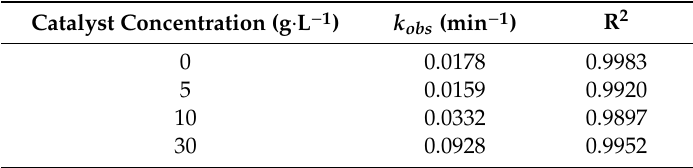
Table 1. Pseudo -first order kinetics for assays testing catalyst concentration.